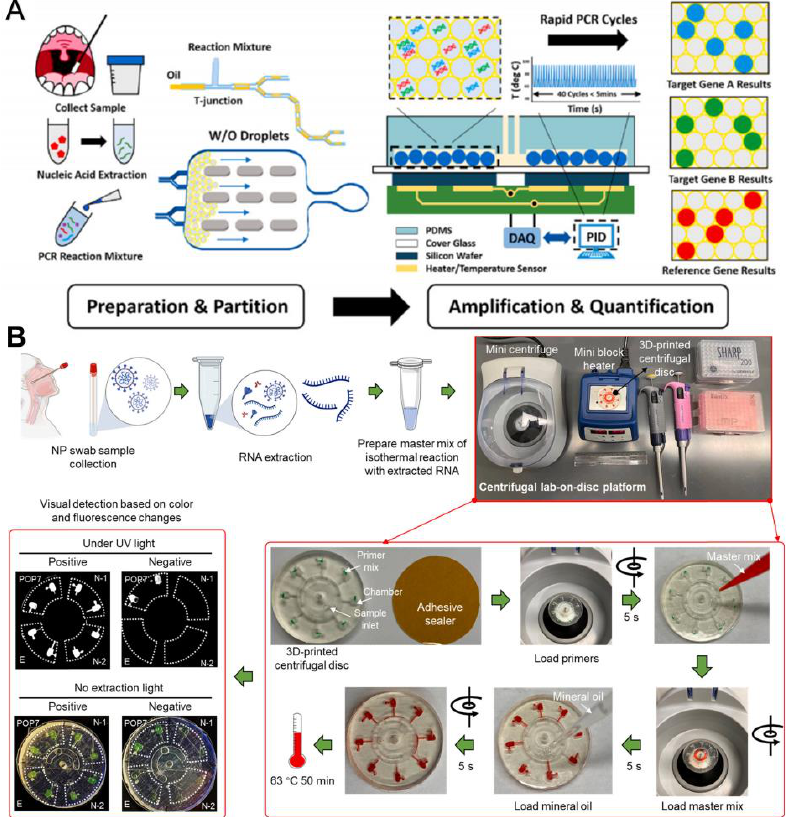
Figure 6. Microfluidic laboratory based on PCR assay. ( A ) Workflow of rapid digital PCR. Reproduced with permission from Yin, H., Biosensors and Bioelectronics , published by Elsevier, 2021 [39]. ( B ) Procedures of the monolithic, 3D-printed lab-on-disk platform for the rapid, multiplexed detection of SARS-CoV-2. Reproduced with permission from Huang, E., Analytical and Bioanalytical Chemistry ; published by Elsevier, 2021 [40].